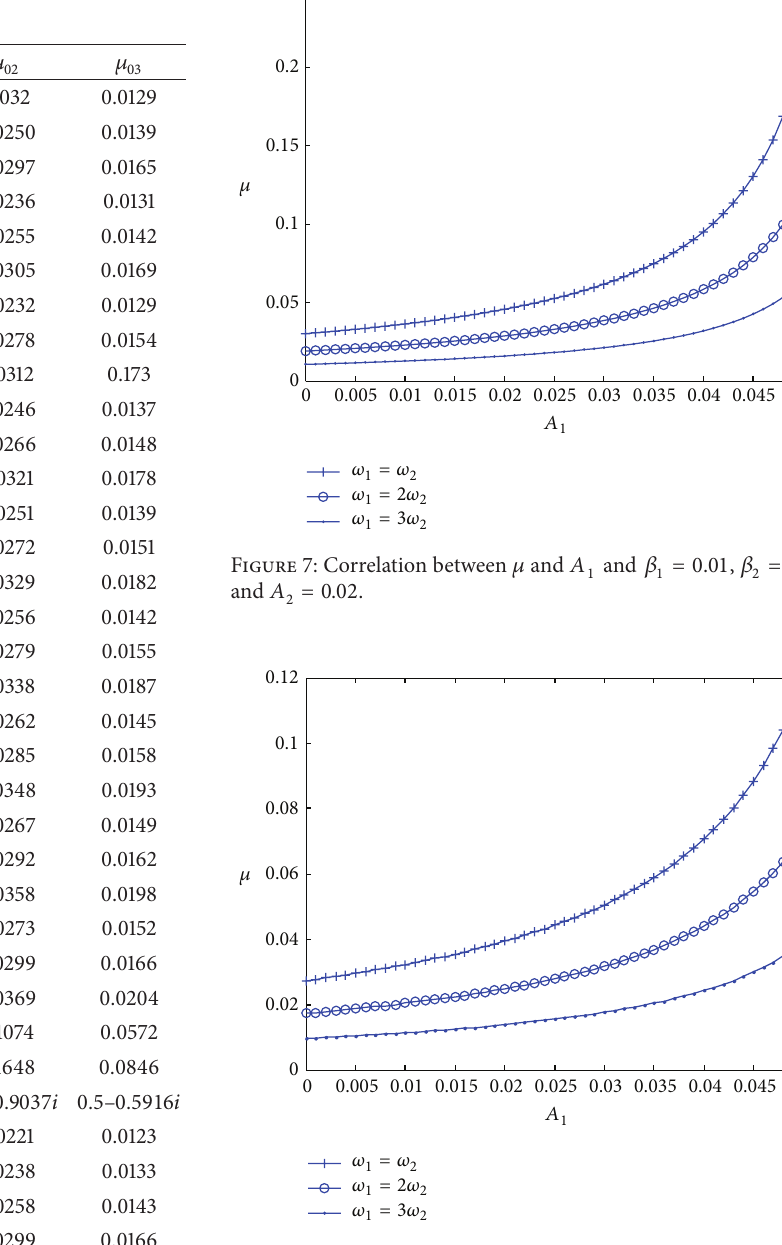
Table 1: Values of 𝜇 01 , 𝜇 02 , and 𝜇 03 for different values of radiation pressure and oblateness parameter.